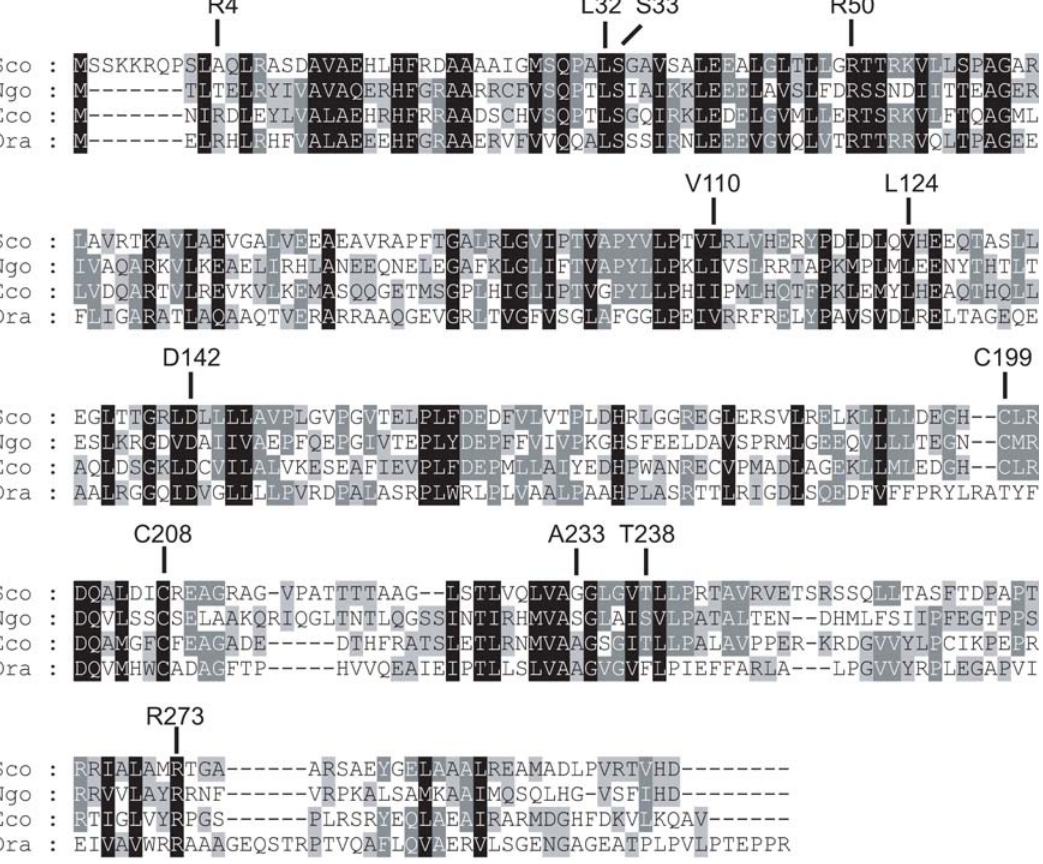
Figure 1. Alignment of OxyR homologs from different organisms. Using CLUSTAL W software aligned amino acid sequences of the Streptomyces coelicolor A3(2), Neisseria gonorrhoeae , E. coli , and D. radiodurans . Identical amino acids are highlighted in black, and conserved residues are highlighted with grey. The DrOxyR helix-turn-helix region has four conserved residues (R4, L32, S33 and R50) [17]. At its LysR-substrate binding domain, D142 and R273 possibly define an activating region on OxyR (contact with RNA polymerase)[18], A233 residue is involved in tetramerization[17], V110, L124, and A233 form a hydrophobic core[58]. Numbering is based on the E. coli OxyR sequence.